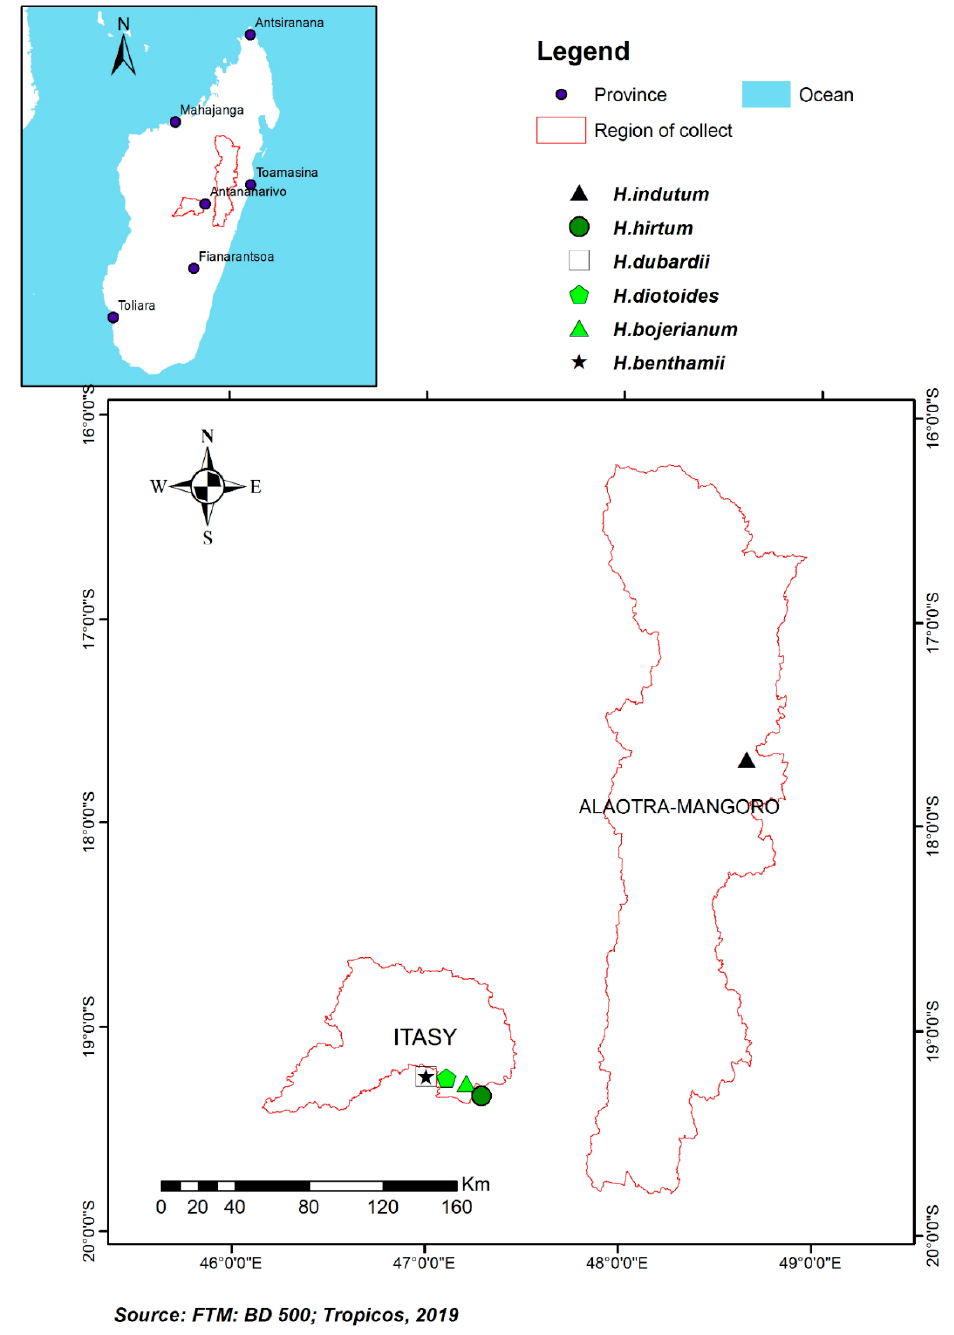
Figure 1. Collection maps of the six Helichrysum species.